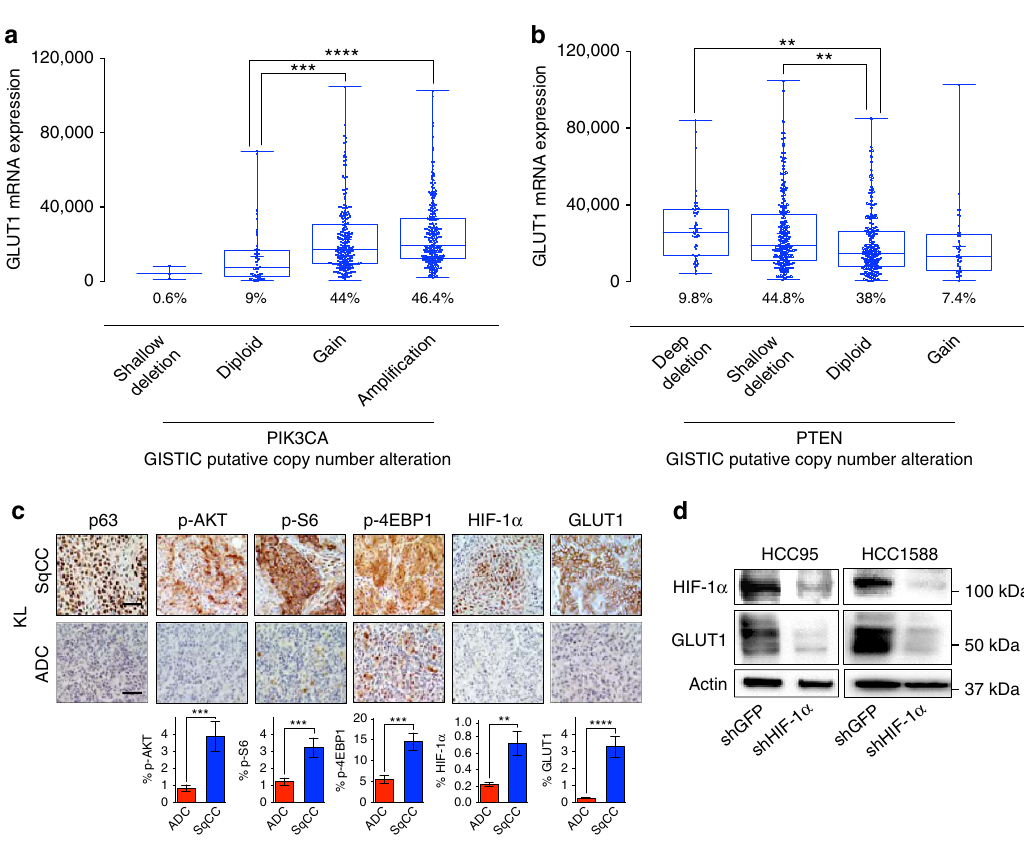
Figure 7 | Elevated PIK3/AKT/HIF-1 a pathways in KL SqCC tumours. ( a , b ) Analysis of TCGA gene expression (normalized TPM) and PIK3CA ( a ) and PTEN ( b ) genomic copy number alteration profiles. Each dot represents one SqCC patient ( n ¼ 501). Boxes represent the interquartile range and whiskers are drawn to the minimum and maximum. Kruskal–Wallis non-parametric ANOVA, **** P o 0.0001, *** P o 0.001, ** P o 0.01. ( c ) IHC analysis (top) and quantification (bottom) of p63, p-AKT, p-S6, p-4EBP1, HIF-1 a and GLUT1 in KL tumours ( n ¼ 6 each group). Two-tailed t -test, **** P o 0.0001, *** P o 0.001, ** P o 0.01. Scale bar, 50 m m. ( d ) Immunoblot analysis of HIF-1 a and GLUT1 in control shGFP and shHIF-1 a knockdown SqCC cell lines, HCC95 and HCC1588. All error bars represent the mean ± s.e.m.